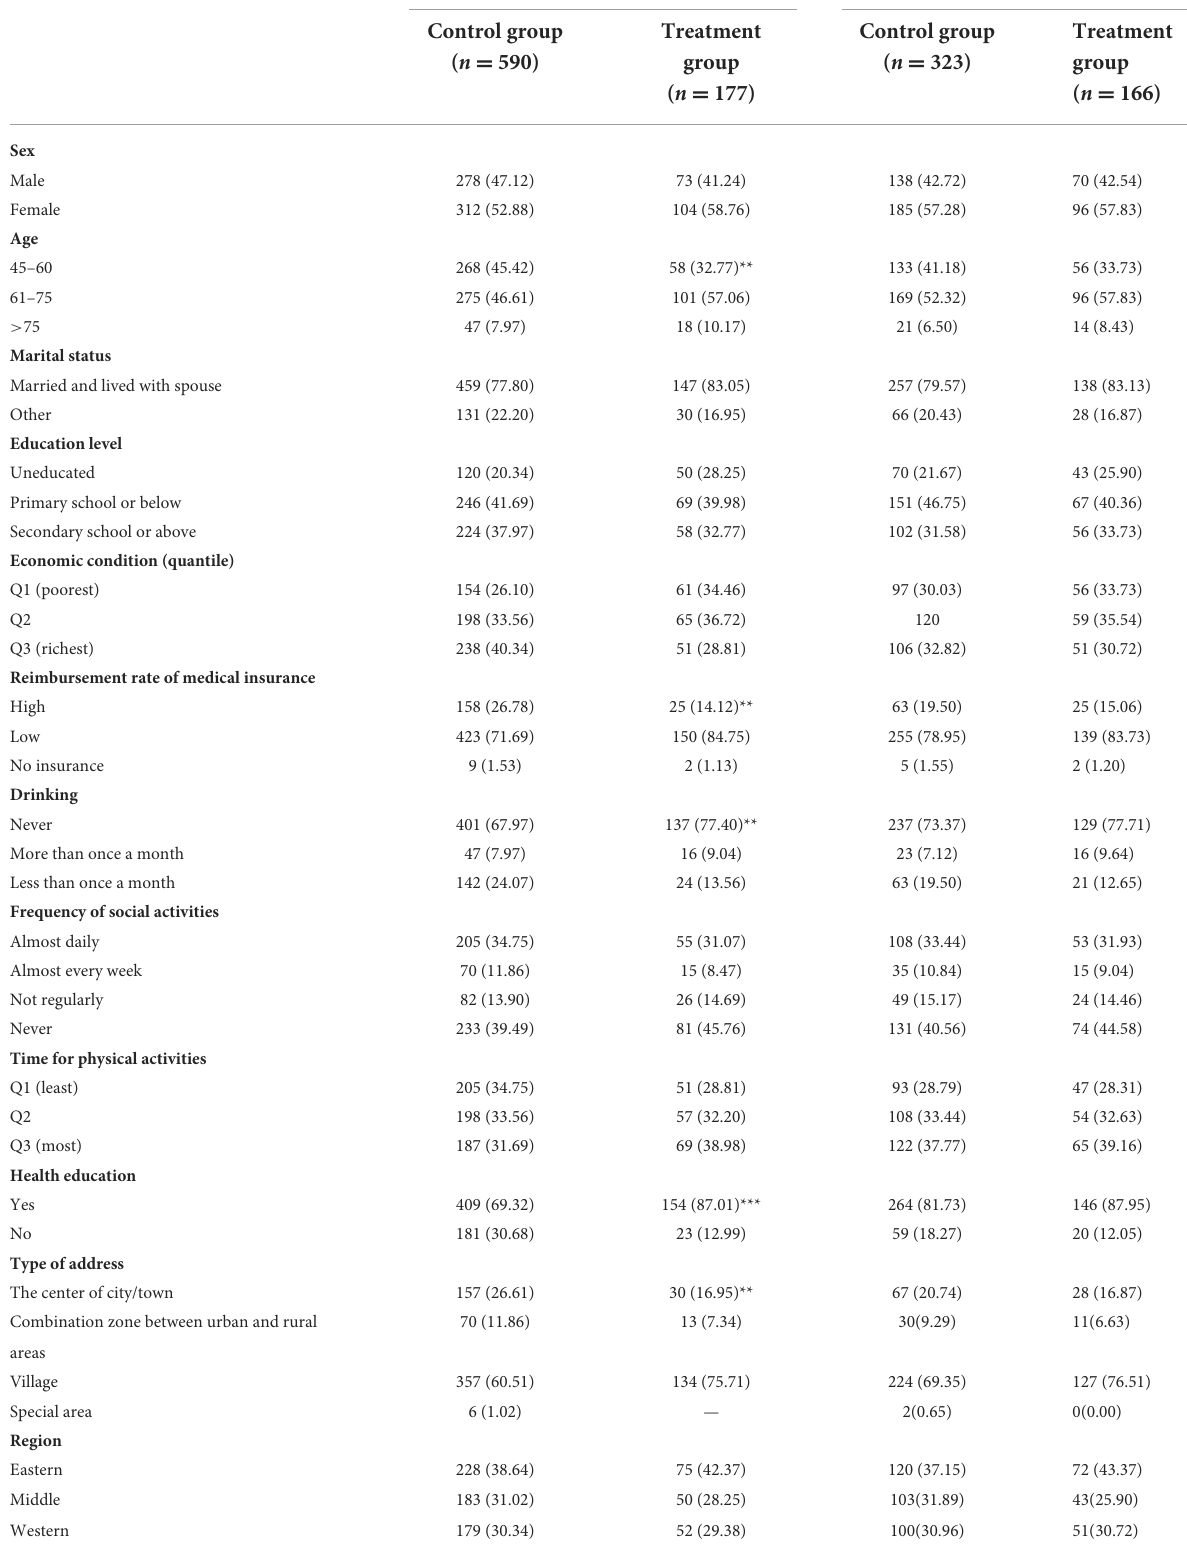
TABLE 1 Characteristics of the